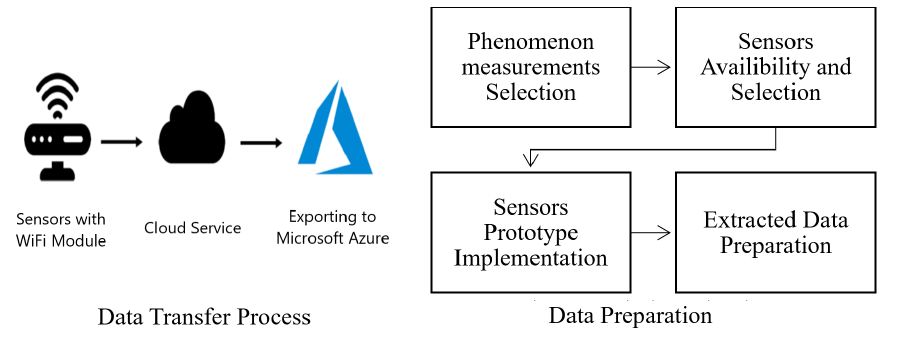
Figure 4. Data Transfer Process and Preparation